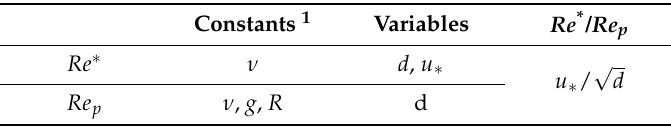
Table 1. The constant and the variable parameters in the equations of the shear Reynolds number ( Re ∗ ) and the explicit particle Reynolds number ( Re p ) (Equations (2) and